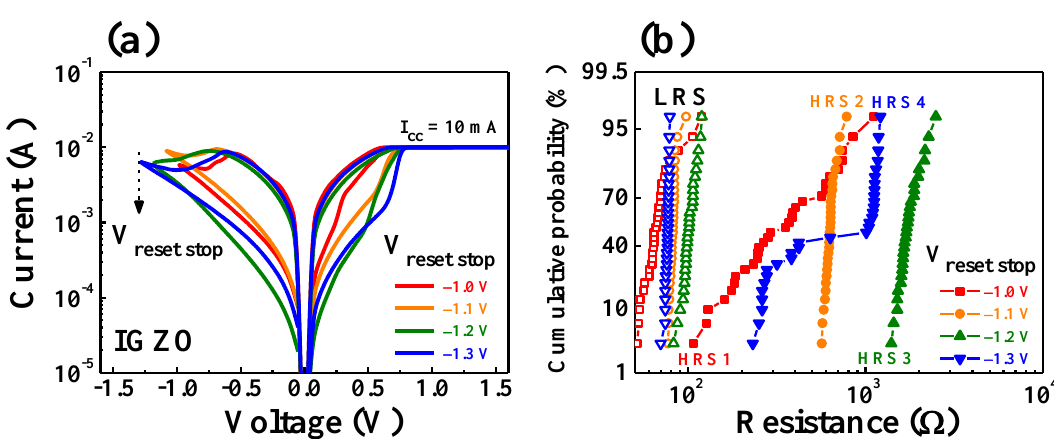
Figure 7. Multi-level resistance characteristics for the IGZO memristor devices by varying the magnitude of V stop values from −1.0 to −1.3 V (in −0.1 V step). ( a ) BRS I–V characteristic curves. ( b ) Cumulative probability during 30 cycles of DC BRS operation.